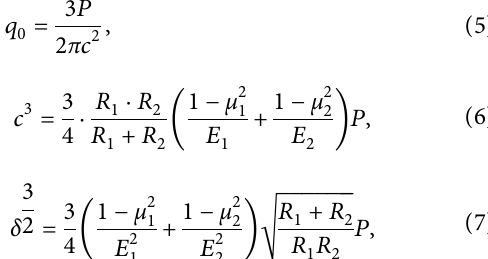
Figure 7: E i –e 0 relationship for PTFE ball